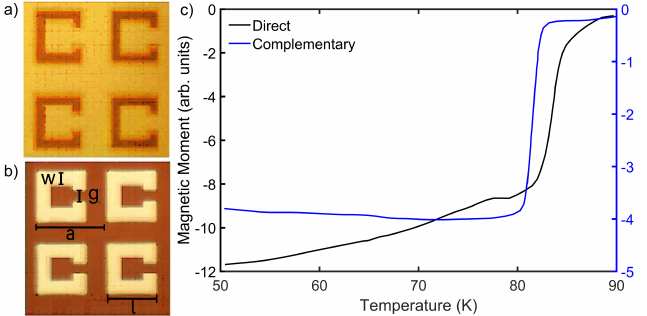
Figure 1. SEM pictures of the direct ( a ) and complementary ( b ) SRR devices. Dark areas mark YBCO film, while light areas mark Al 2 O 3 substrate. The geometrical details are l = 20 µ m, g = 5 µ m, w = 5 µ m, and a = 30 µ m. ( c ) Magnetic moment measurements for the direct and the complementary device,